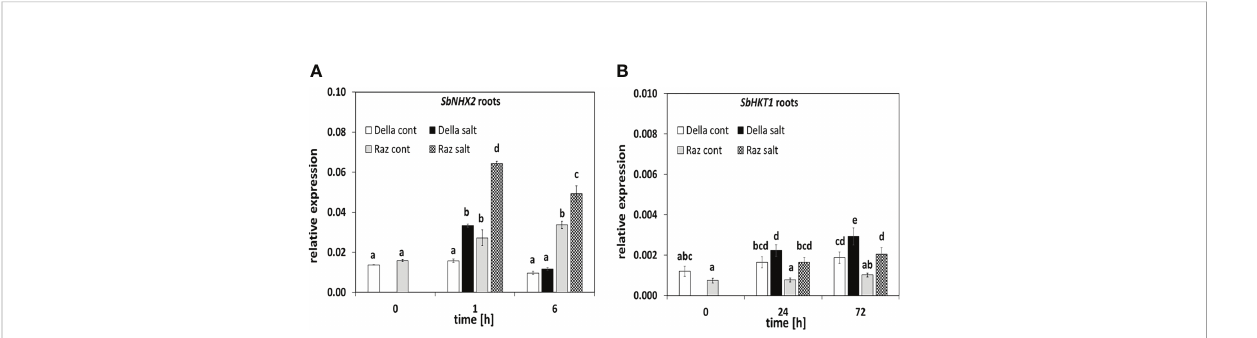
FIGURE 4 The steady-state transcripts level of salt stress-related genes in sorghum roots. Thirteen days old Della (white bars), and Razinieh (gray bars) seedlings were stressed in aqueous NaCl (100 mM) solution to measure steady sate transcripts of (A) SbNHX2 after 1, and 6 h and (B) SbHKT1 after 24 h and 72 h after salt treatment. Values represent the mean of at least three independent biological replicates ± SE. Different letters show signi fi cant differences between different genotypes and treatments according to Duncan ’ s test ( P <